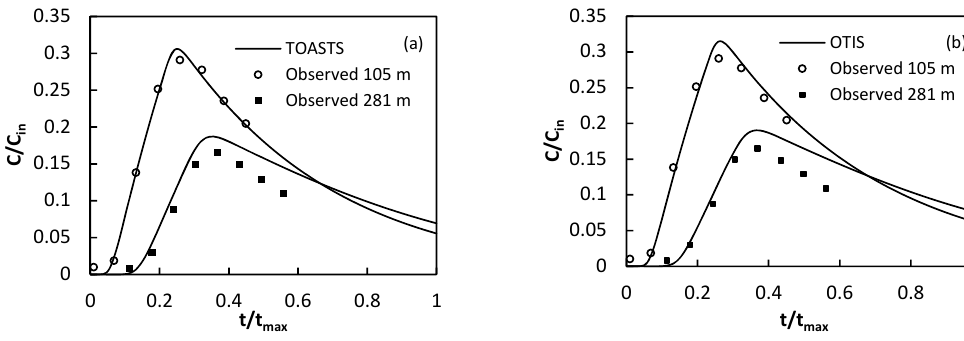
Figure 17. Observed and simulated sorbate strontium concentrations in the Uvas Creek experiment (test case